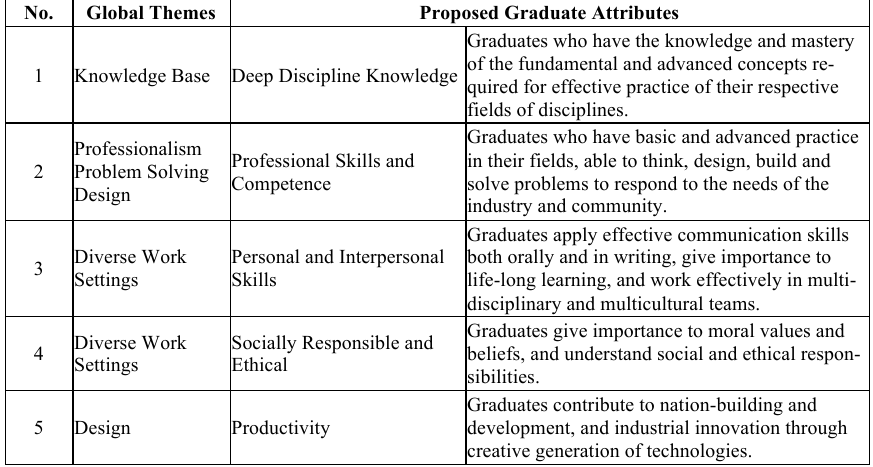
Table 3. Proposed CSPC Graduate Attributes